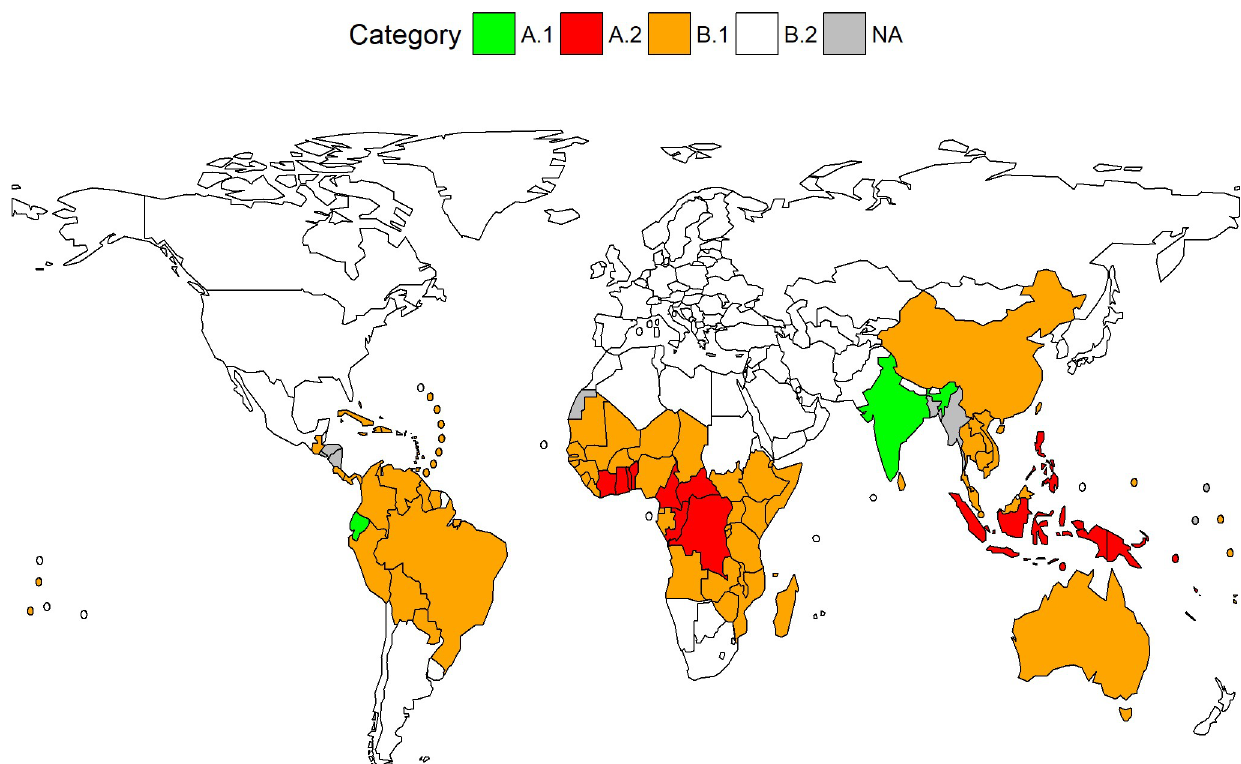
Fig 1. Yaws endemicity status, 2015. A.1: Interrupted transmission; A.2: Currently endemic; B.1: Previously endemic (current status unknown); B.2: No history of case reports. References to yaws were found for another 7 Member States, displayed here as not available (NA) because of non-specific case reports: Bangladesh, El Salvador, Honduras, Marshall Islands, Myanmar, Nauru and Nicaragua. In addition to Member States, there are 9 countries or areas with a history of yaws for which categorization is not displayed on this map: British Virgin Islands, French Guiana, Guadeloupe, Guam, Martinique, Montserrat, New Caledonia, Puerto Rico, and Wallis and Futuna Islands. Created using R and World Health Organization shapefiles under Creative Commons license